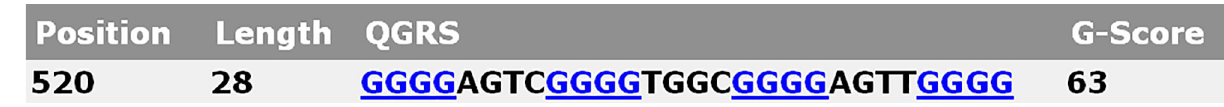
Fig 2. G-quadruplex prediction. QGRS mapper prediction of G-quadruplex for the IGFN1 intron15 displayed a PQS with score 63.